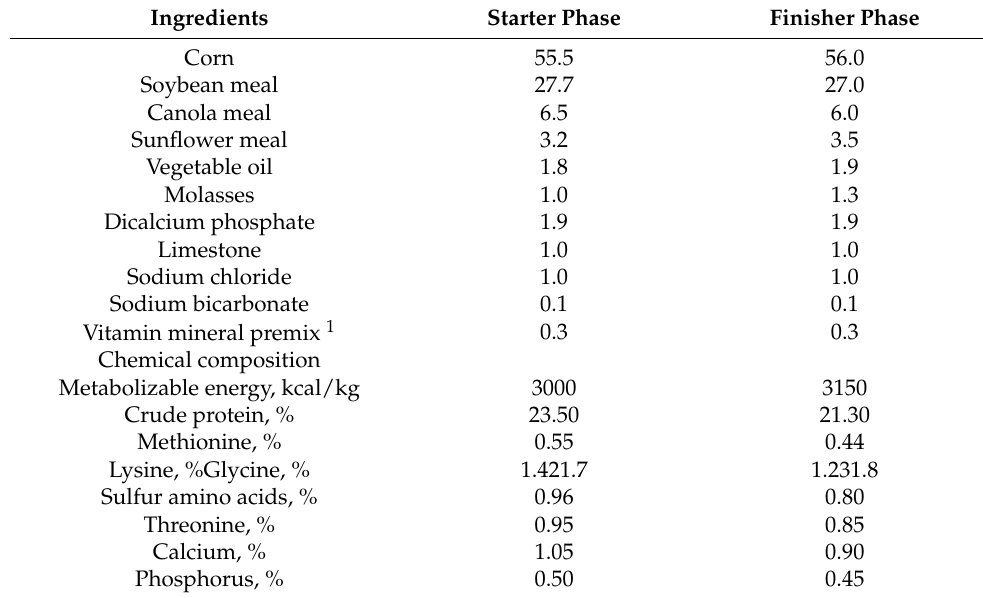
Table 1. Ingredients and chemical composition of basal diets fed to broiler chickens. Ingredients